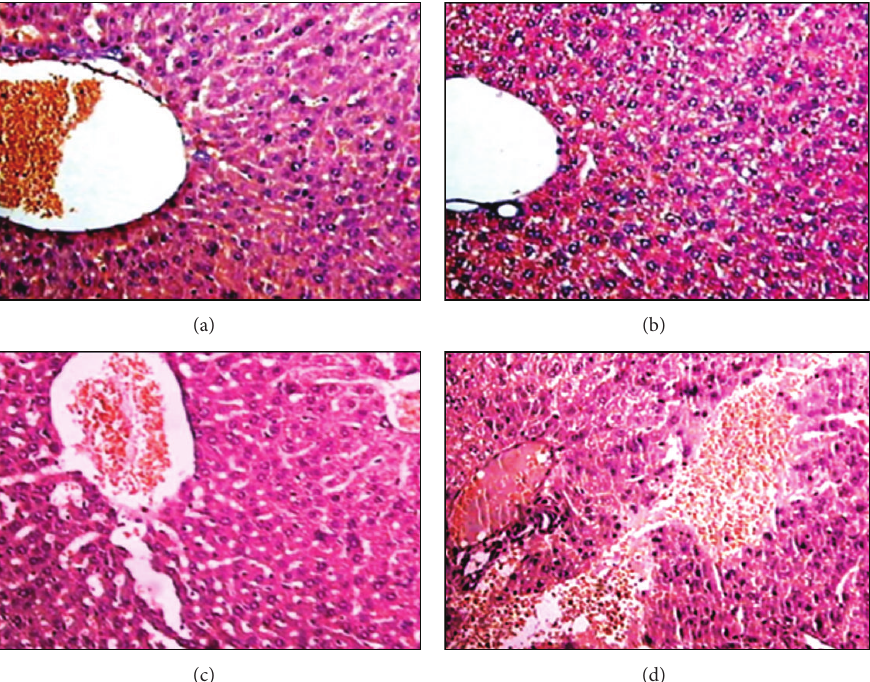
Figure 4: Liver histological analysis of mice acutely exposed to diphenyl ditelluride 250 𝜇 mol/kg. (a) Liver section of control group showing preserved polygonal hepatocytes with oval-shaped nuclei, dispersed chromatin, and prominent nucleolus cordially arranged towards hepatic central vein; (b) liver section of diphenyl ditelluride treated mice showing microvesicular steatosis and macrovesicular steatosis; (c) presence of sinusoidal dilatation mainly in centrilobular and mediolobular areas; (d) hepatocytes with pyknotic nuclei surrounded area with vascular congestion and hepatic laminae disorganized (H&E 10x). The picture is a representation of three independent